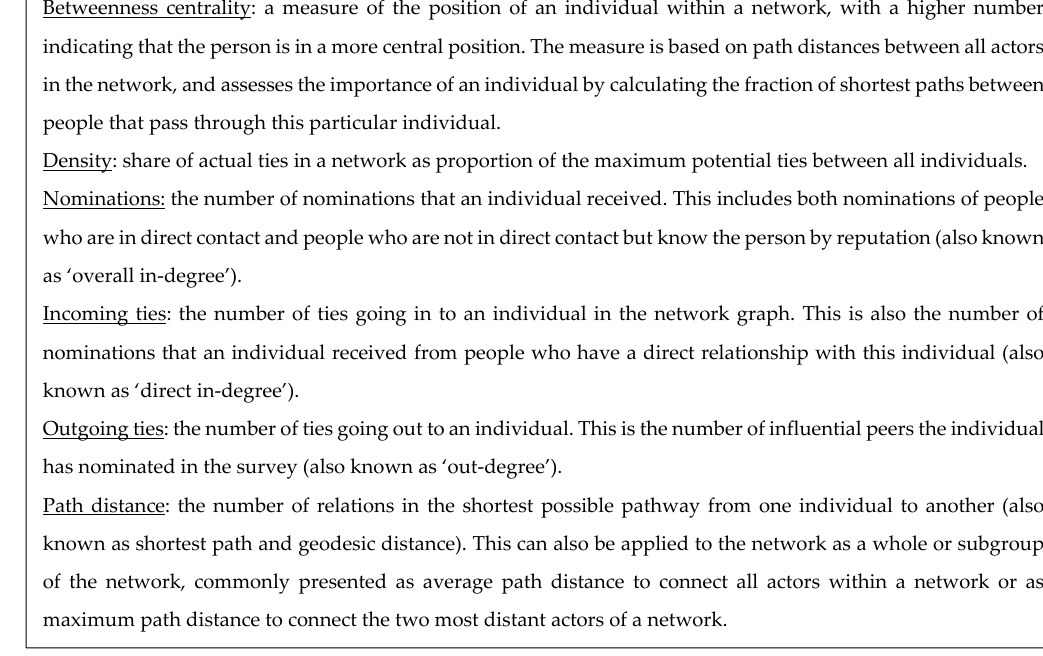
Figure 2. Centrality measures used for this study.